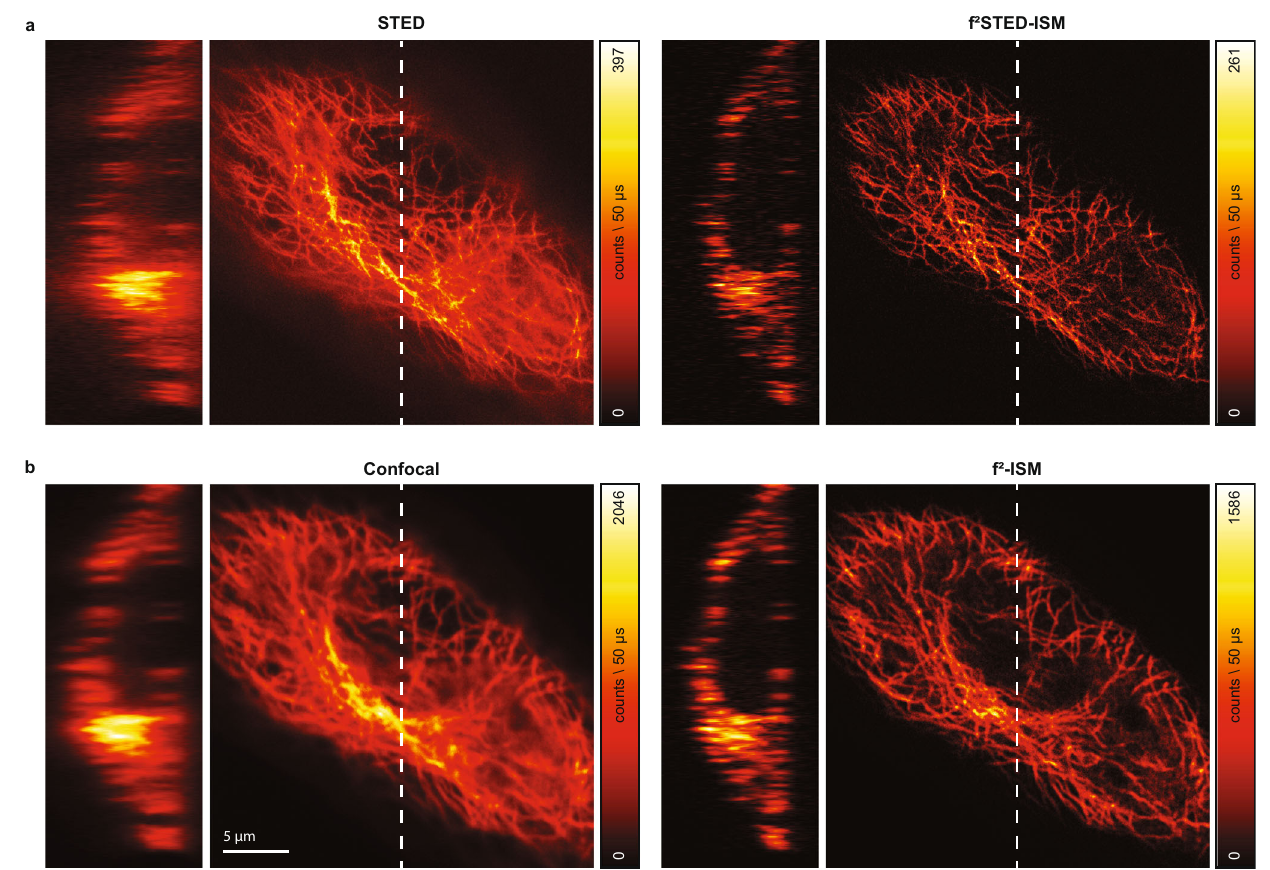
Fig.6|Volumetricfocus-ISM. In( a ),weshowtheSTEDimageofatubulin-labelled fi xed Hela cell (left). The f 2 -ISM reconstruction (right) show negligible loss of in- focus photons and greatly enhanced contrast, obtained by removing the out-of- focuscontent.In( b ),weshowtheconfocalimageofthesamecell(left).Eveninthis